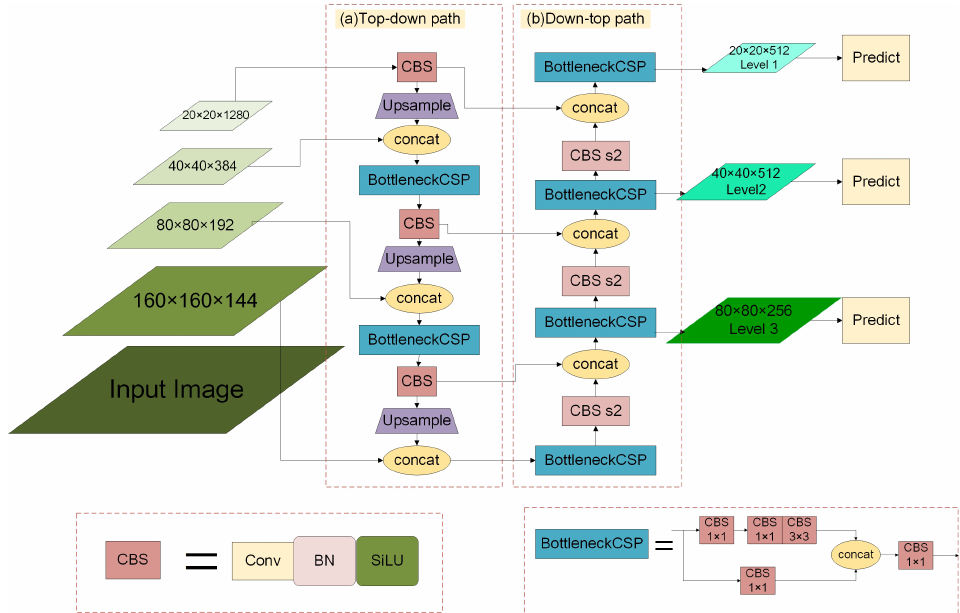
Figure 3. The structure diagram of Multi-scale Feature Enhancement Fusion network. CBS represents the convolution module with stride 1. CBS s2 represents the convolution module with stride 2. BottleneckCSP (BC) represents the combination of convolution